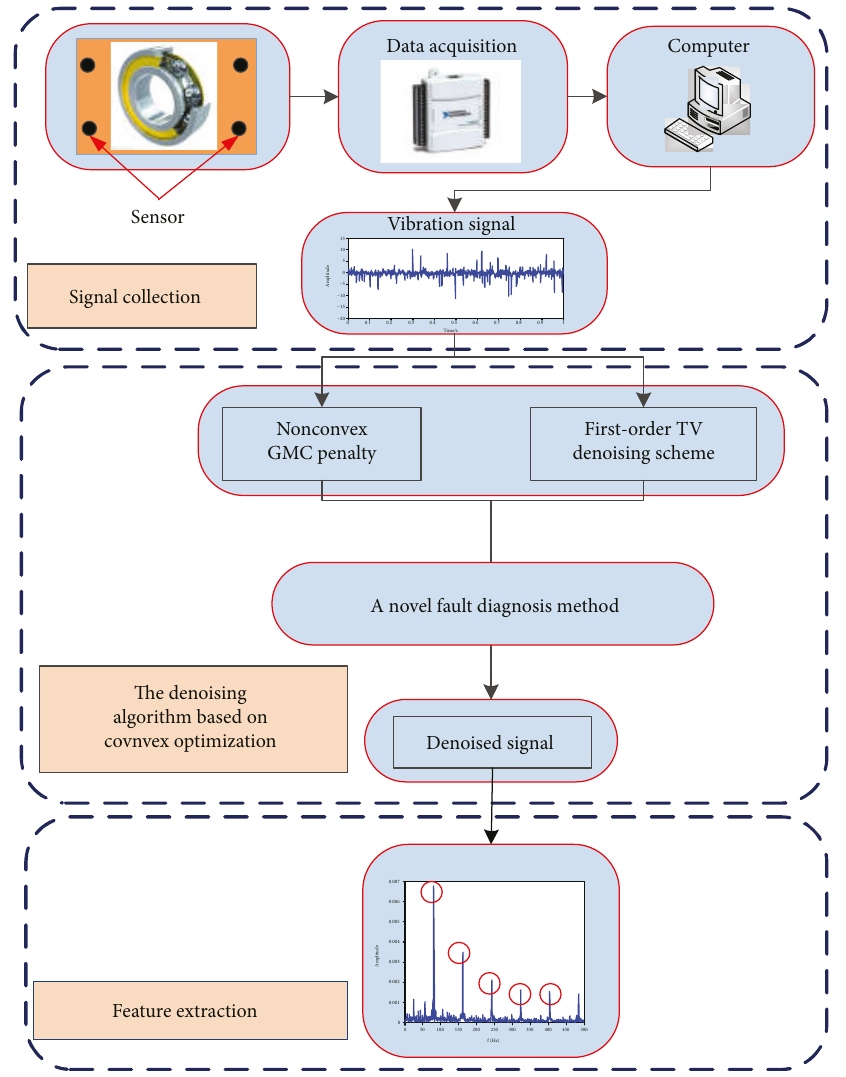
Figure 2: The fl owchart of the method presented in this